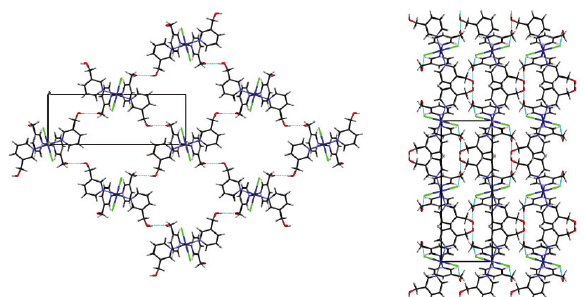
Figure 2. ORTEP view of CoCl (3PM) molecule in 1 . Thermal el- Figure 4. A layer of molecules in polymorph 1 connected by 2 4 lipsoids are drawn at the 25% probability level. Only the atoms of hydrogen bonds between the hydroxyl groups viewed along a axis the asymmetric unit are labelled. Due to the similarity of the mole- (left) and formation of a three-dimensional structure through addi- cular entities the labelling scheme pertains also to 2 and 3 . tional O–H···Cl hydrogen bond (right) viewed along c axis.